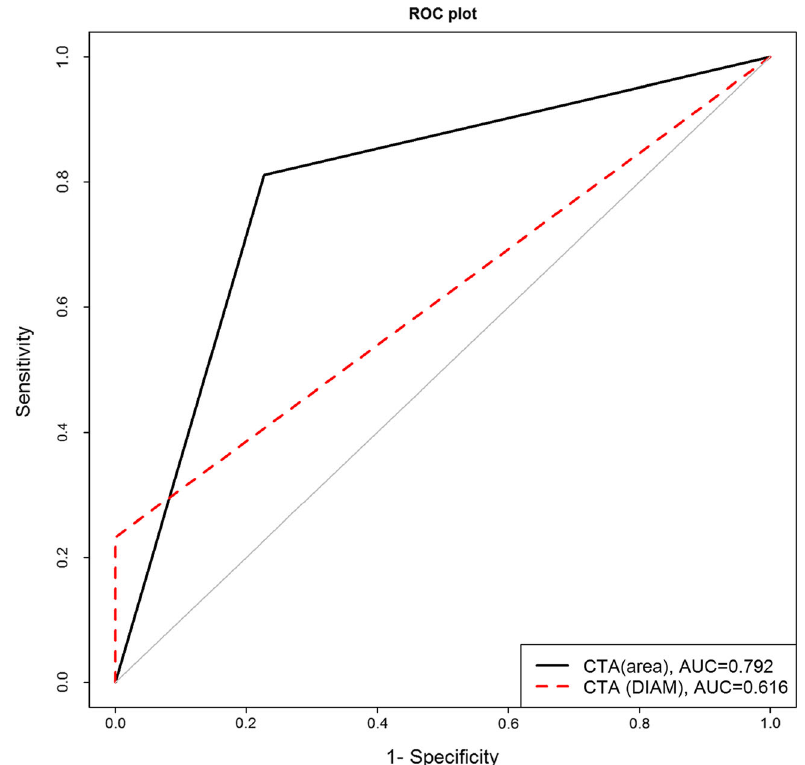
demonstrating the specificity and sensitivity of both CTA (area) and CTA (diameter) methods in identifying surgical stenosis